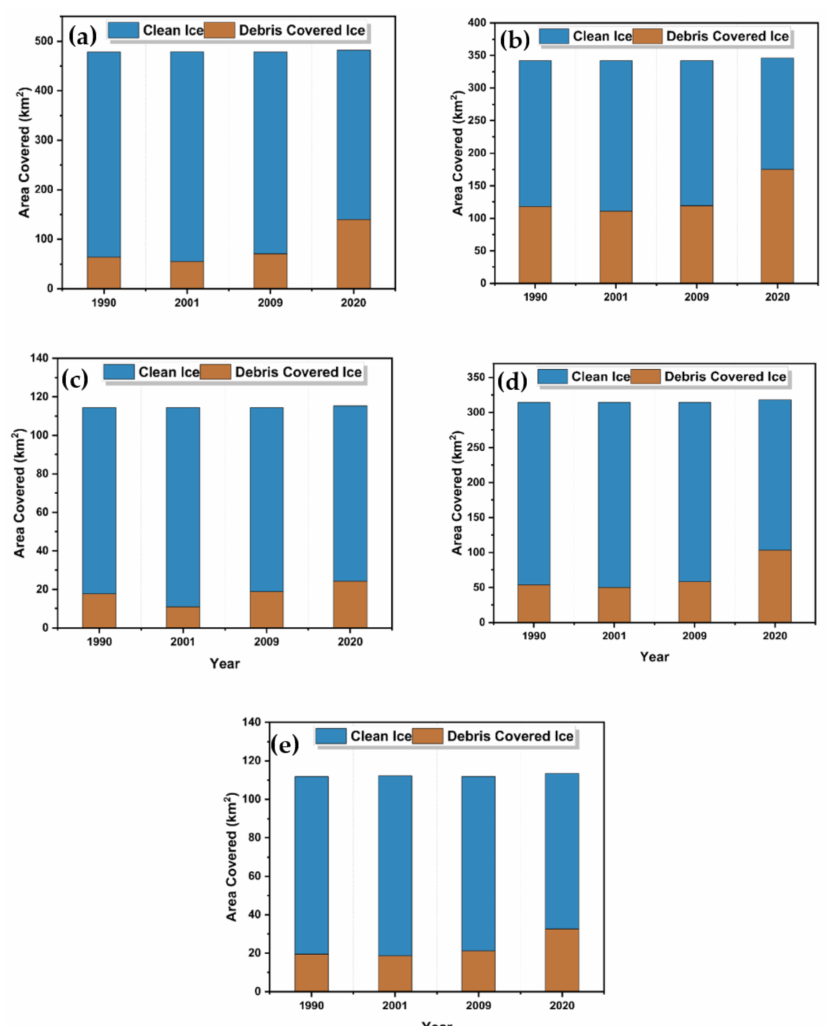
Figure 5. Glacier area changes from 1990–2020. ( a ) Biafo, ( b ) Hispar, ( c ) Khurdopin, ( d ) Panmah, and ( e ) Virjerab.